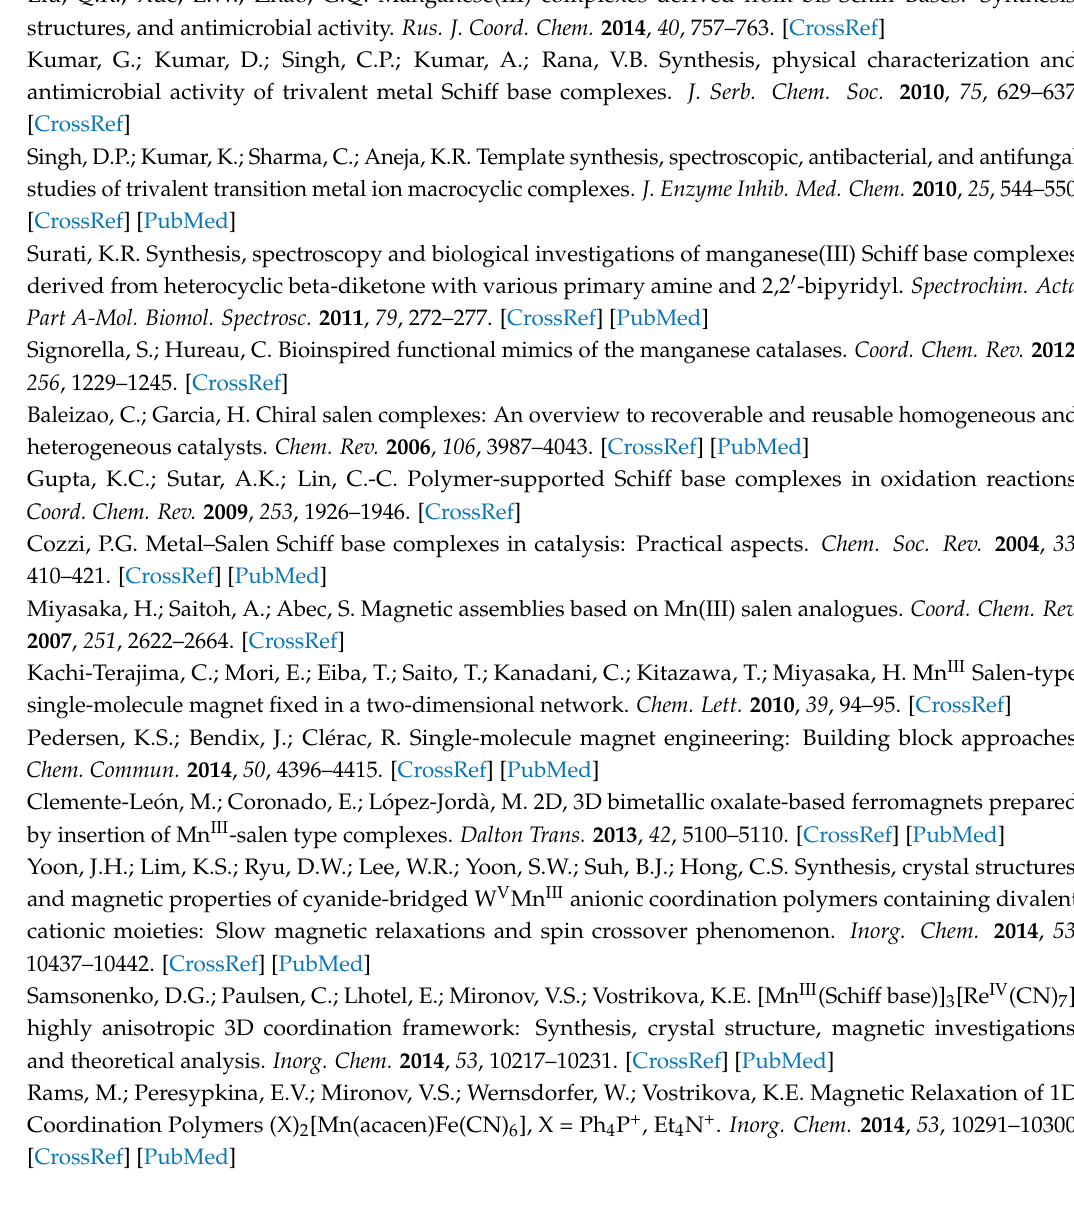
pellets. Table S3. Selected bond lengths (Å) and angles (deg.) for {Re(CN) 7 }